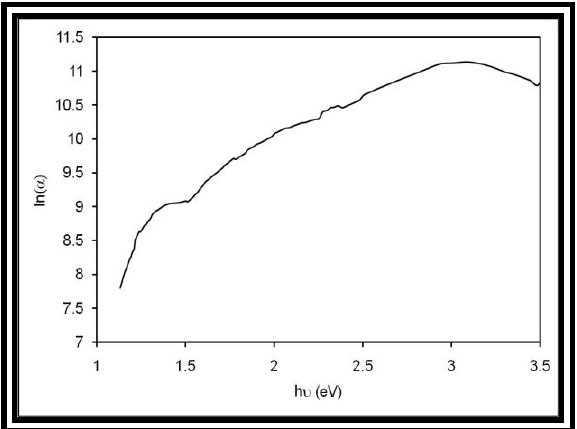
Fig.6: Absorption coefficient as function of energy photon of copper oxide thin film